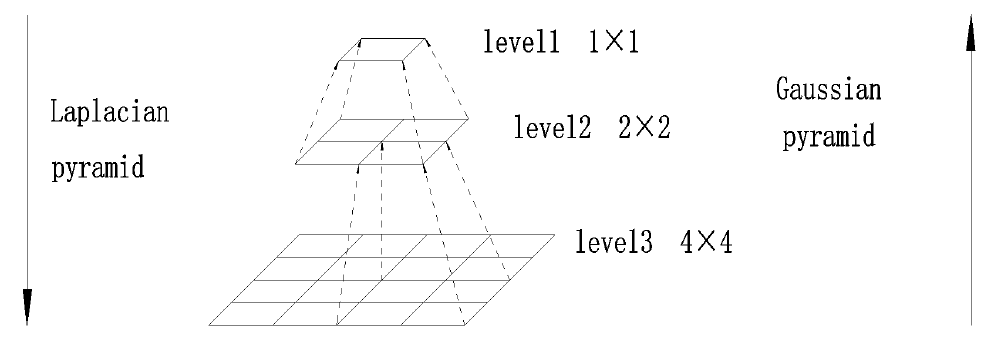
Figure 2. The sample of the Gaussian pyramid and the Laplacian pyramid, where the upward arrow denotes an up-sample operator, and the downward arrow represents a down-sample